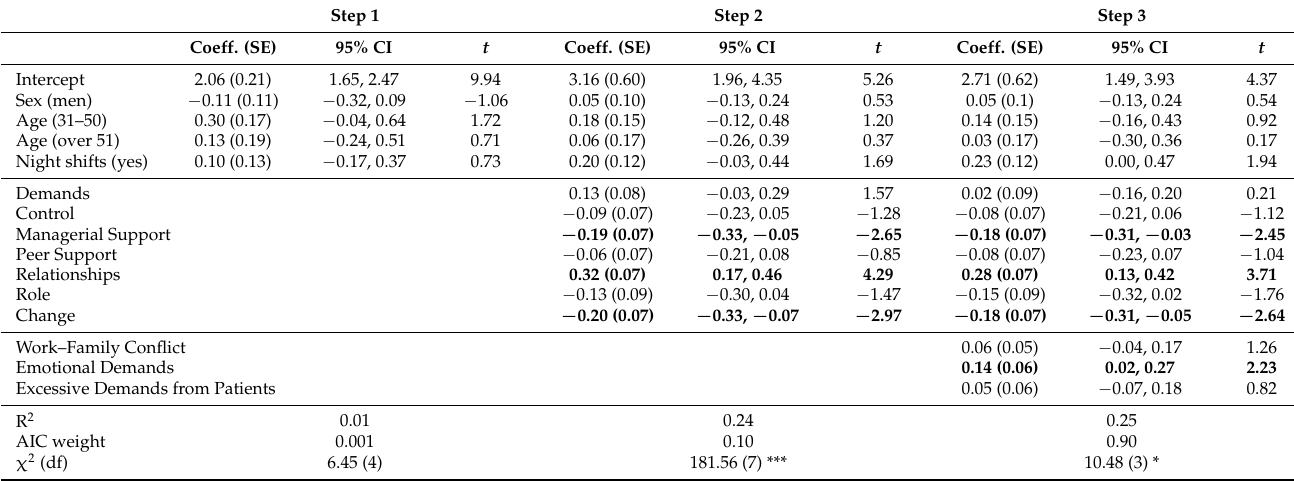
Table 3. Model comparison and parameter estimates for Turnover